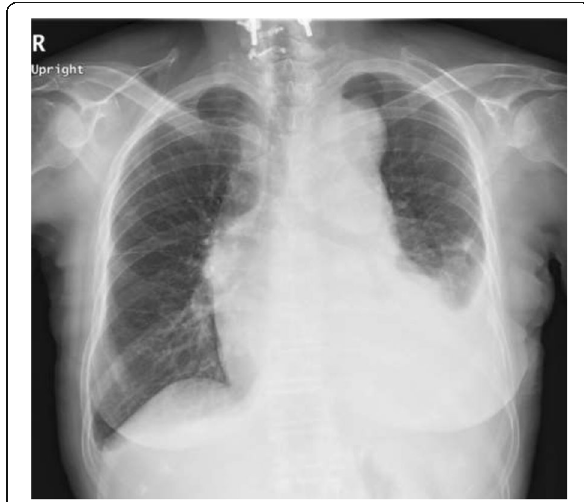
Fig. 1 Preoperative chest X-ray showing blunting of the left